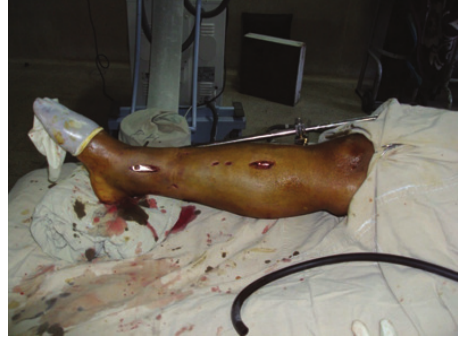
Figure 2: Insertion of the plate with minimally